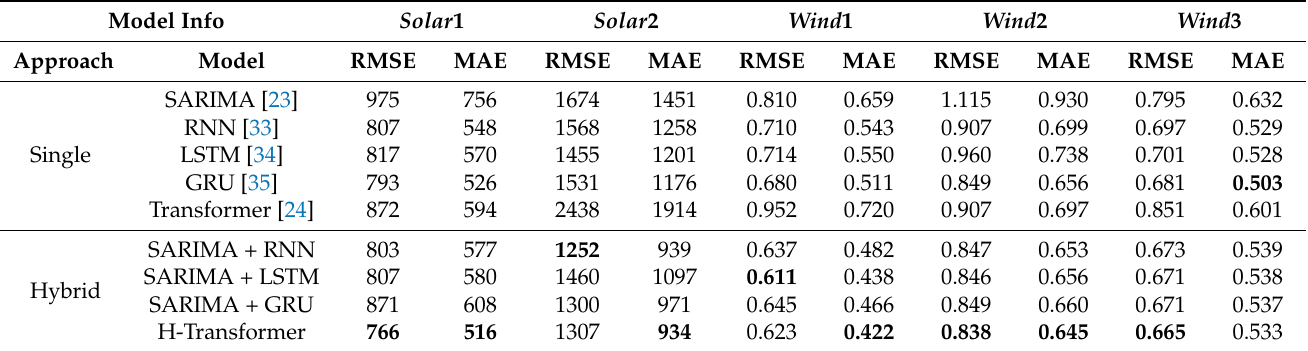
Figure 4. The percentage difference (Equation (11)) between H-Transformer and literature methods in terms of MAE. Table 3. RMSE and MAE performance metrics of the H-Transformer, single and hybrid approaches for renewable time series. The best value for each time series is highlighted in bold. The error in Solar dataset predictions are in KWh, and in m/s for Wind